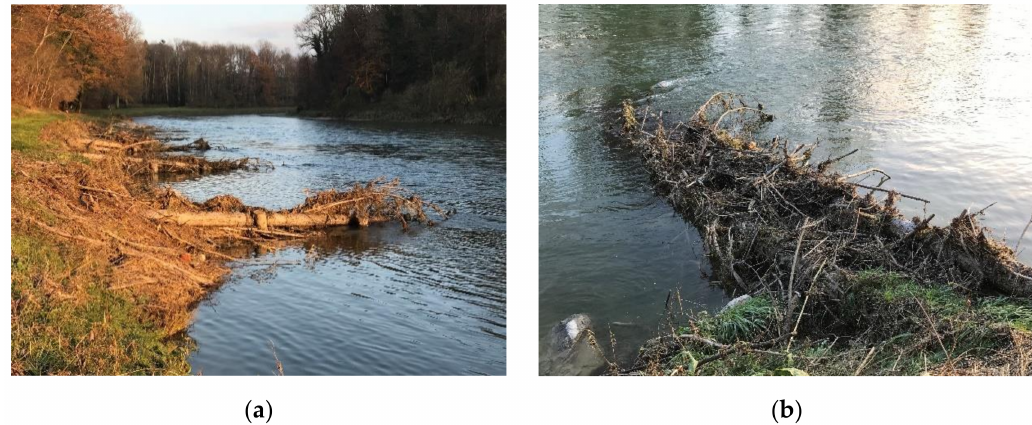
Figure 7. ( a , b ) Almost completely submerged tree groins as bank protection; Thur River; Photo: M.